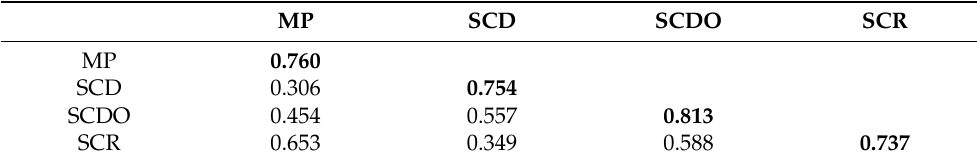
Table 4. Fornell–Larcker